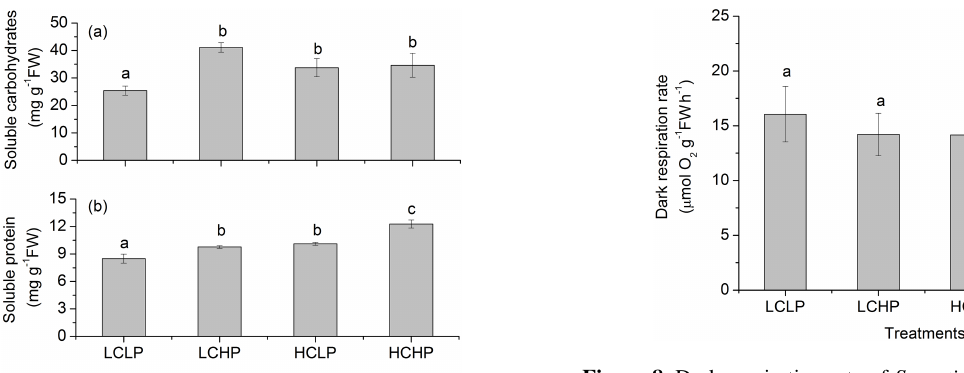
Figure 8. Dark respiration rate of S. muticum after being grown at different p CO 2 and P conditions for 13 days. Data are reported as means ± SD ( n = 3). LCLP is the low p CO 2 and low P condition, LCHP is the low p CO 2 and high P condition, HCLP is the high p CO 2 and low P condition, and HCHP is the high p CO 2 and high P condition. Different letters above the error bars indicate significant differences between treatments ( P < 0 .